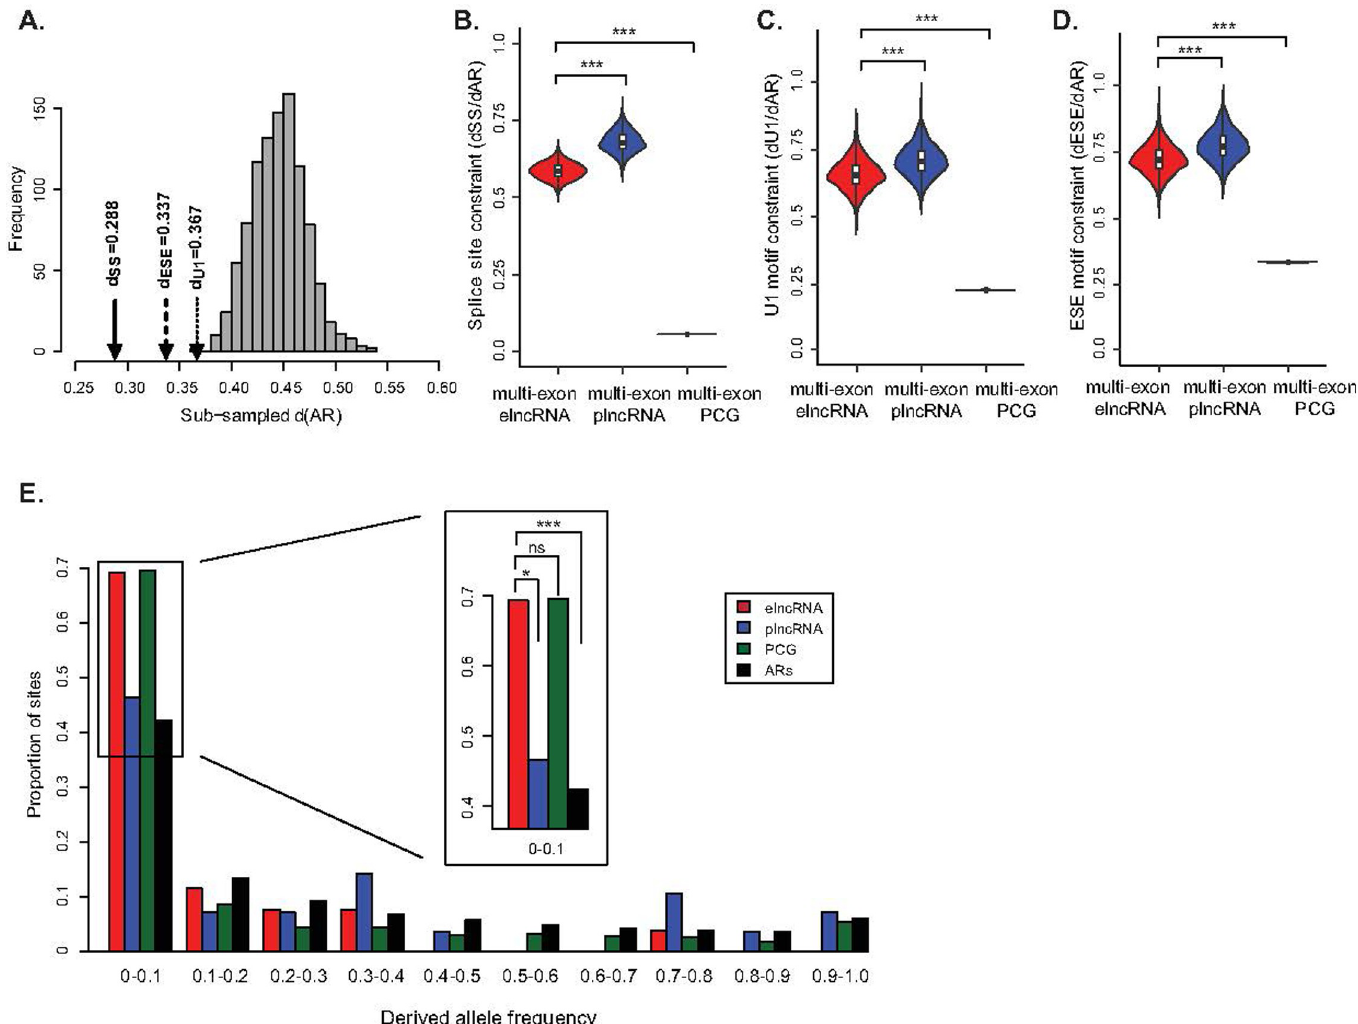
Fig 1. Splicing of elncRNAs has evolved under purifying selection. (A) Distribution of pairwise nucleotide substitution rate between human and mouse for 1,000 randomly subsampled sets of local ancestral repeats (ARs) with matching GC-content and size as splicing related motifs (grey). The observed rate observed at splice sites (d SS, solid line arrow), ESE (d ESE , dash line arrow), and U1 (d U1 , dotted line arrow) sites within multi-exonic elncRNAs. Distribution of nucleotide substitution rate relative to that of randomly subsampled local ARs (d AR ) for (B) splice sites, (C) ESEs, and (D) U1s within multi-exonic elncRNA (red), plncRNA (blue) and protein- coding gene (dark green). Differences between groups were tested using a two-tailed Mann-Whitney U test. ��� p < 0.001. (E) Distribution of derived allele frequency (DAF) for single nucleotide variants at splicing motifs (splice sites, ESEs and U1s) within multi-exonic elncRNAs (red), plncRNAs (blue), protein-coding genes (dark green), and ARs (black). The insert illustrates variants with low derived allele frequency (DAF < 0.1). Differences between groups were tested using a two-tailed Fisher’s exact test. � p < 0.05; ��� p < 0.001; NS p >